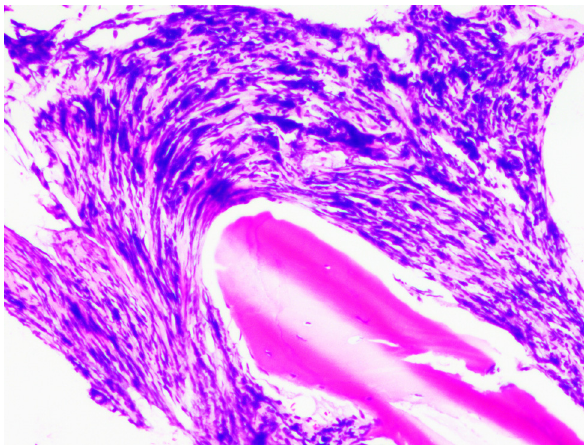
Figure 3: Histopathological fi ndings of the BMB performed on case 2 showing moderate in fi ltration of cells between trabeculae ( hematoxylin and eosin, 100 ×)